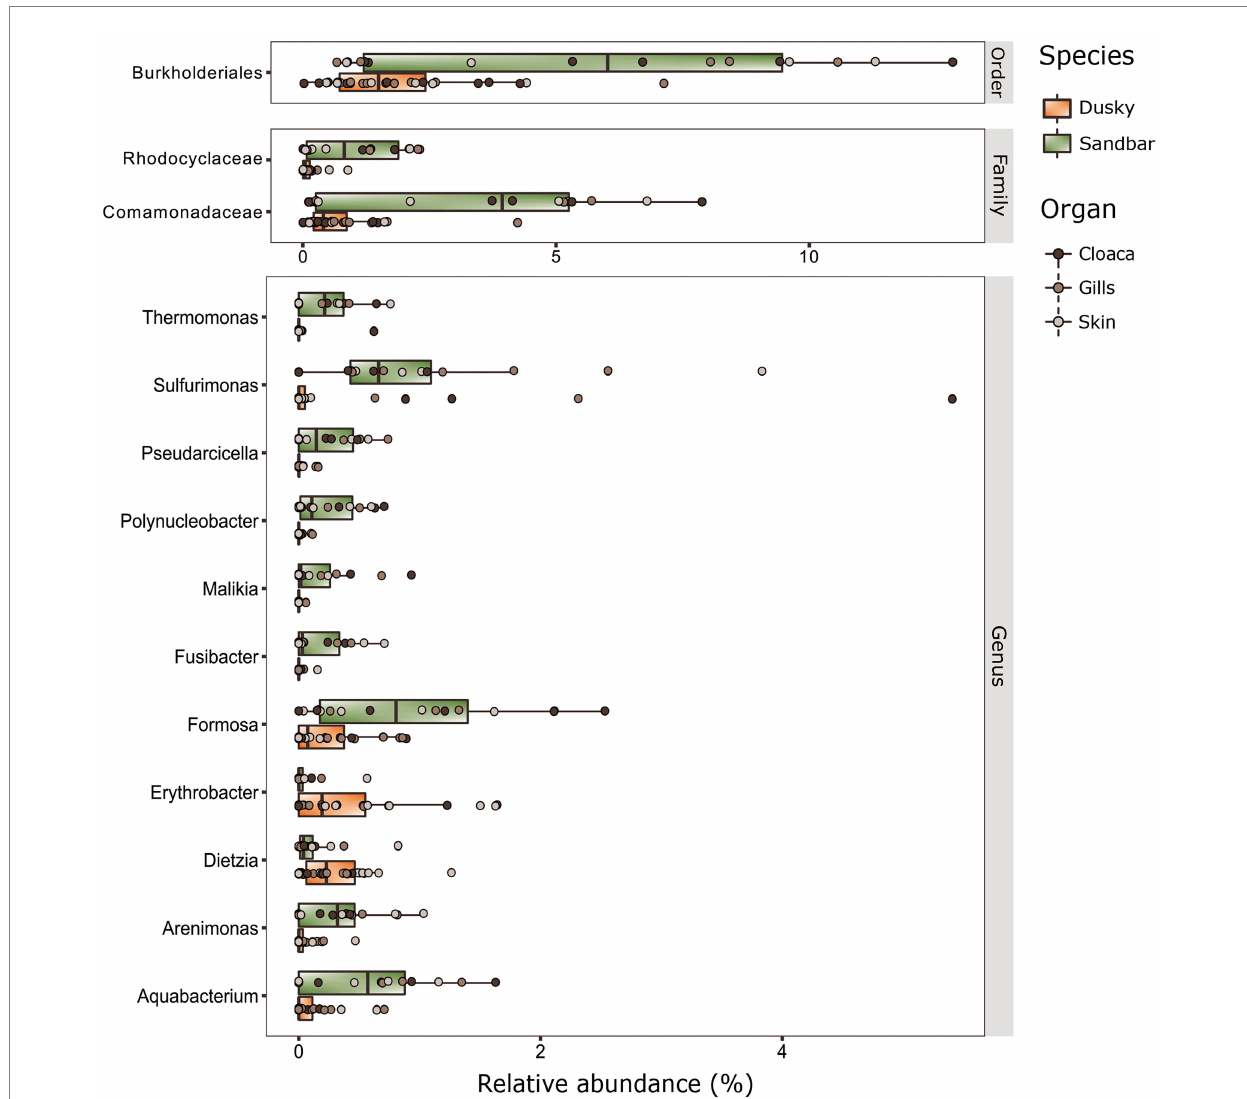
FIGURE 4 Biomarkers at the taxonomy levels (Order, Family and Genus) of dusky and sandbar sharks across three distinct anatomic locations were identified by the linear discriminant analysis effect size (LEfSe) methods (adjusted p < 0.05, LDA >